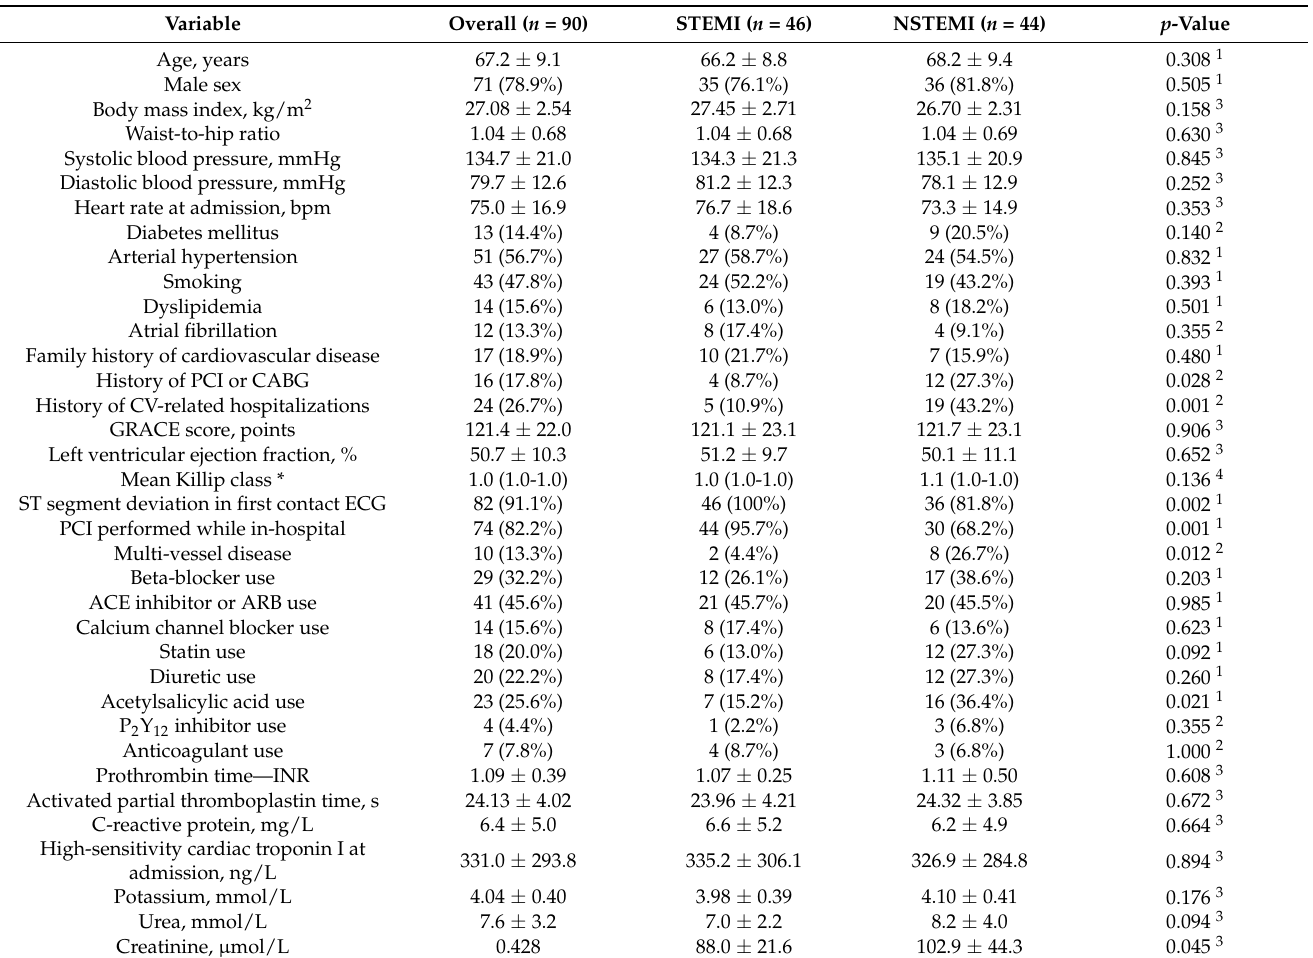
Table 1. Baseline characteristics of patients.